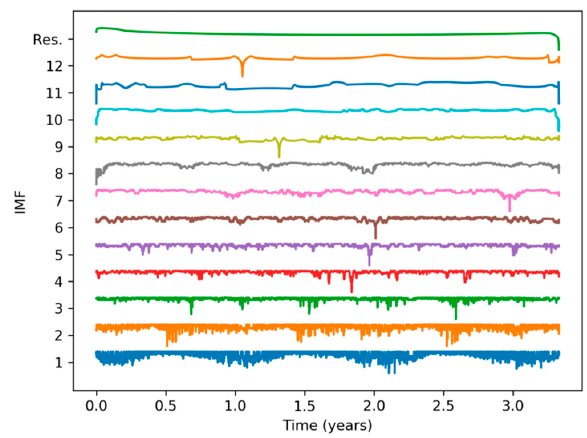
Figure 22. Instantaneous amplitude logarithmic likelihood for every IMF of electricity demand.